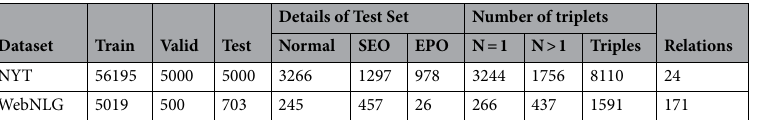
Table 2. Statistics of datasets used in our experiments where N is the number of triples in a sentence.